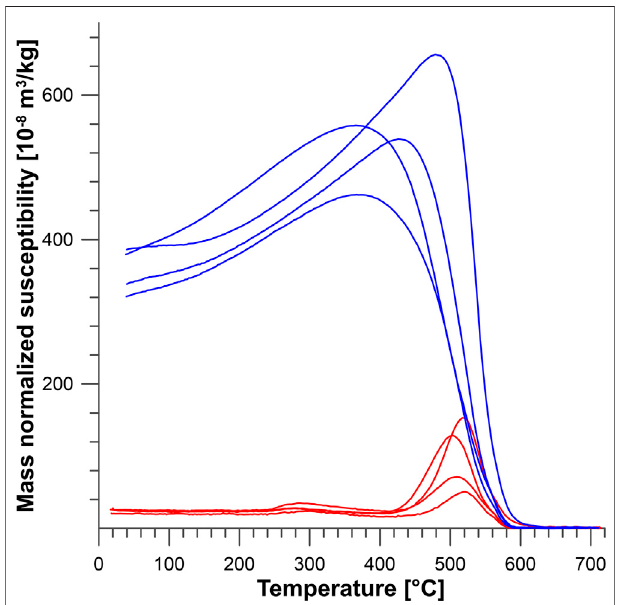
FIGURE 5 | Temperature dependent magnetic susceptibility of four selected samples. Heating is plotted in red, cooling is depicted in blue. Note the increase at ∼ 300 ° C, and decrease at ∼ 580 ° C indicative of a magnetite